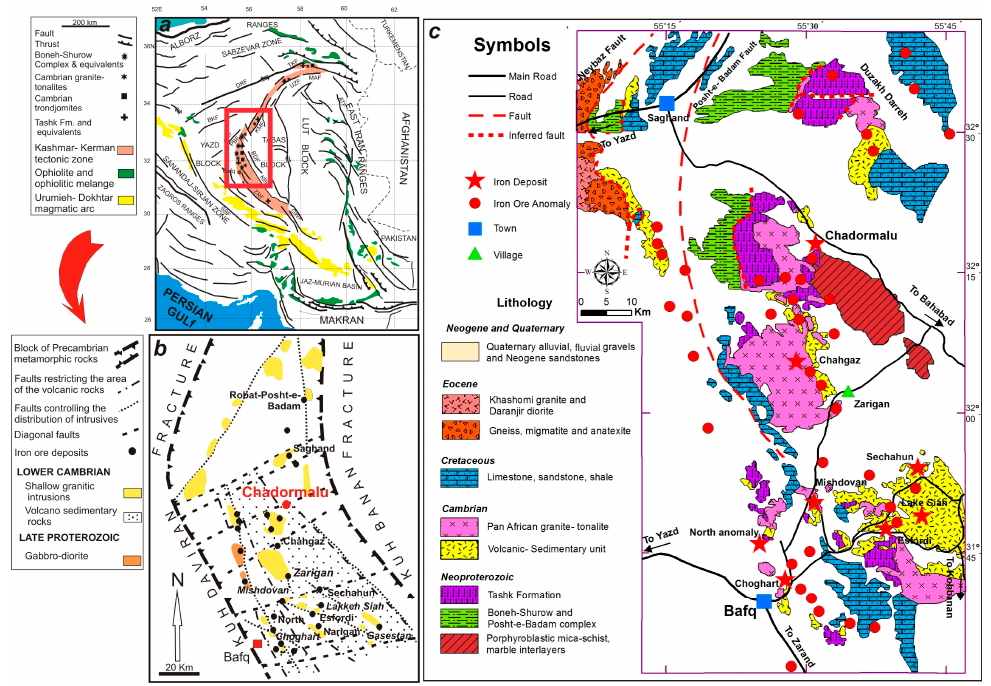
Figure 1. ( a,b ) Distribution of iron oxide-apatite deposits in the Kashmar-Kerman volcano-plutonic belt (modified after [19]); ( c ) Geological map of the Posht-e-Badam area (modified after